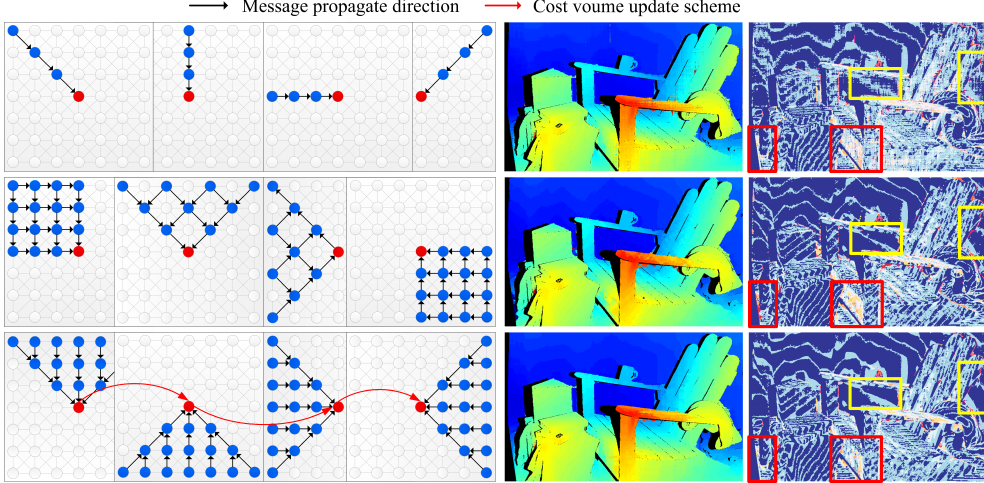
Figure 1. Message propagation strategies and the results on Adirondack stereo images of SGM, MGM and our proposed OmniSGM in four directions (from top to bottom). Black line and red line indicate the directions of how message is propagated and the cost volume update scheme respectively. Black boxes in error maps show that our method and MGM successfully avoid streak artifacts in disparity image, and red boxes demonstrate that our result is more accurate result than that of MGM and